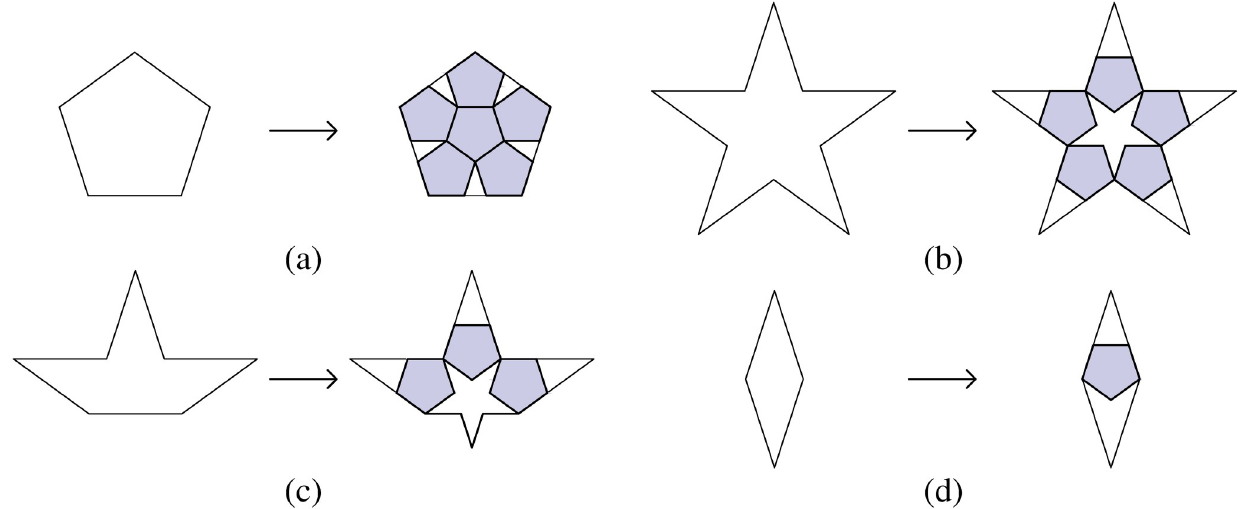
Fig 4. Substitution rules for Penrose tiling (reconstructed from [9]). (a) A pentagon is partially filled by 6 pentagons. (b) A pentacle is partially filled by 5 pentagons. (c) A half-pentacle is partially filled by 3 pentagons. (d) A rhombus is partially filled by 1 pentagon.